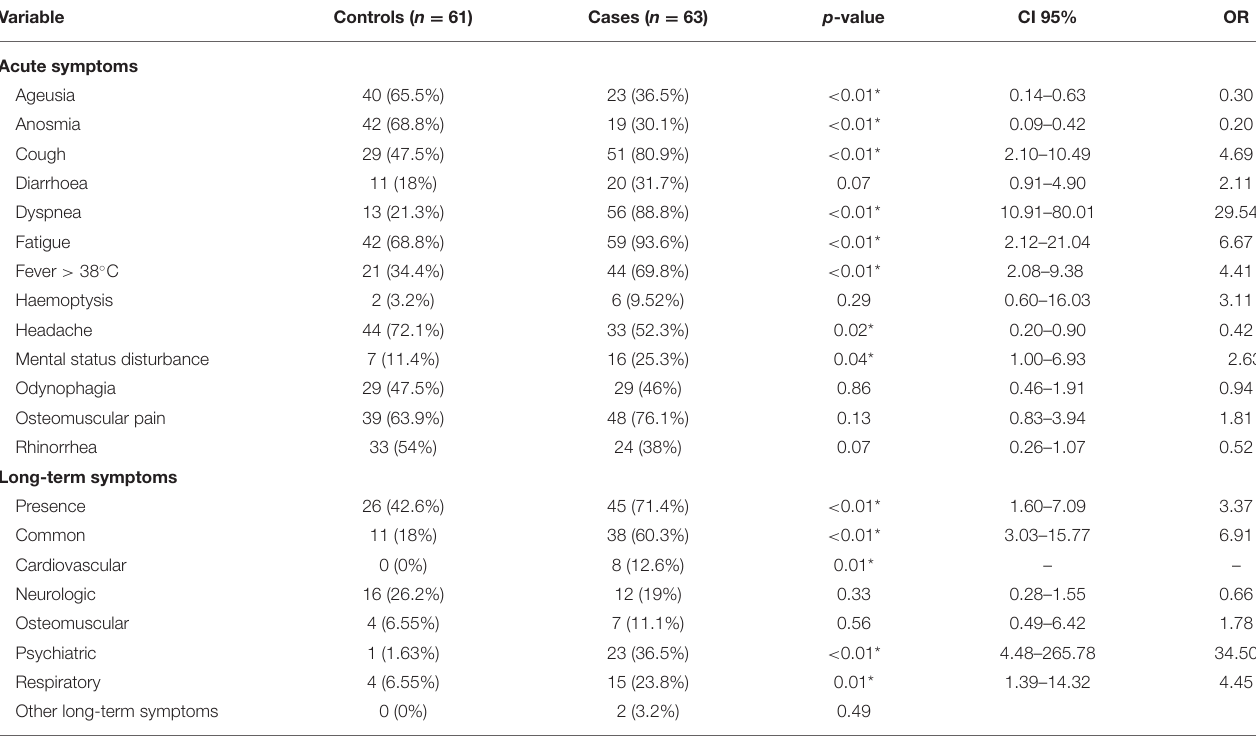
TABLE 2 | COVID-19 symptoms in the studied population.